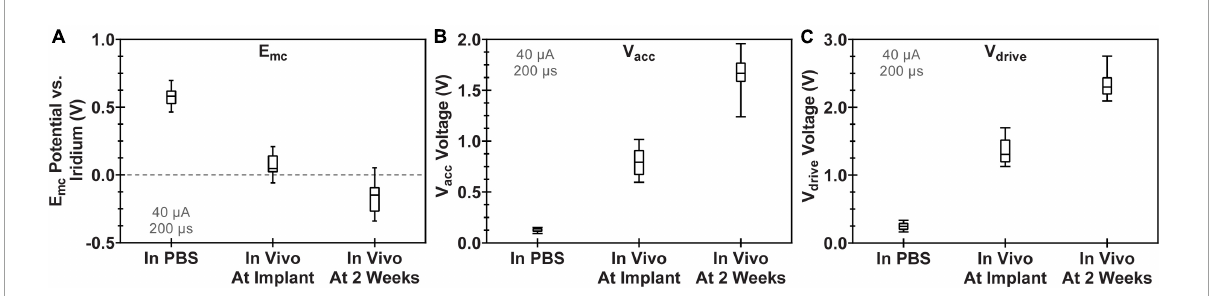
FIGURE6 Comparison of voltage transient parameters for WFMA electrodes after manufacture (VTs recorded in PBS), at the time of device implantation, and 2 weeks after device implantation (before beginning the 24-h pulsing study). All VTs were recorded in response to 40 µ A, 200 µ s pulses at